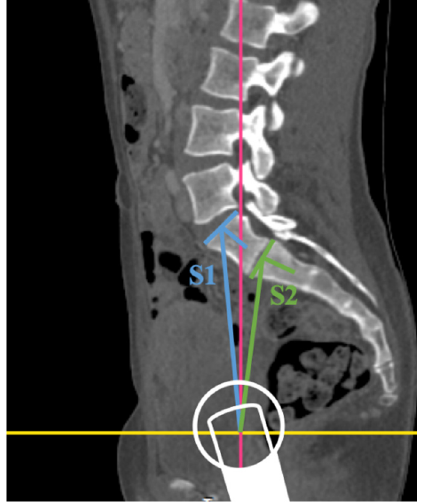
Figure 4. Illustration of the two measurement points S1 (true L6, blue) and S2 (true S1, green) in an LSTV patient with lumbarization and six lumbar vertebrae, classified as Catellvi type IIIa by the example of PI in the multiplanar reconstruction of an abdomen–pelvis CT (in this sectional view, the intersection of the yellow and red line represents the bicoxofemoral axis; schematic illustration of the femoral head).